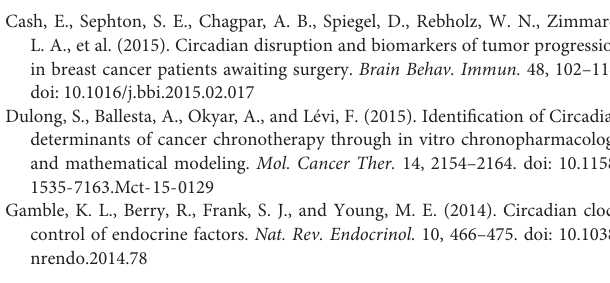
Supplementary Table 7 | Raw data from the 235 patient samples of Cox